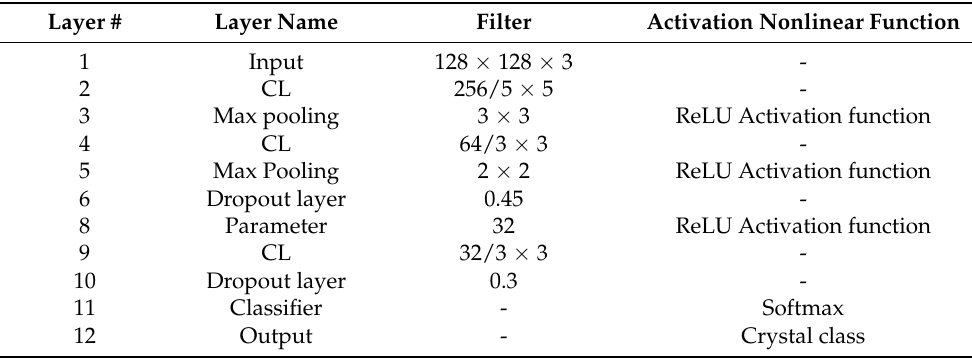
Figure 1. ( a ) 2D mapping of the crystal structure of a substance. ( b ) The transfer learning model is trained to extract the transferable features using the open quantum compounds dataset. Table 2. Proposed CNN model layers and